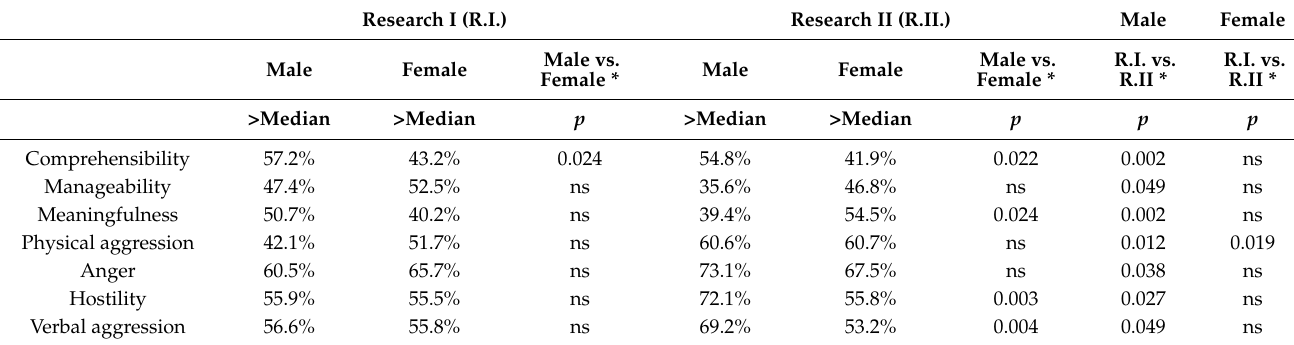
Table 2. Characteristics of the main outcome variables in the samples by